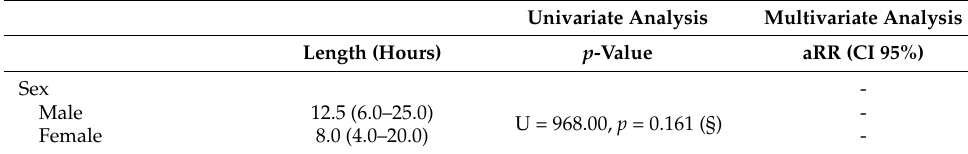
Table 4. Associations with the total length of episodes in the emergency